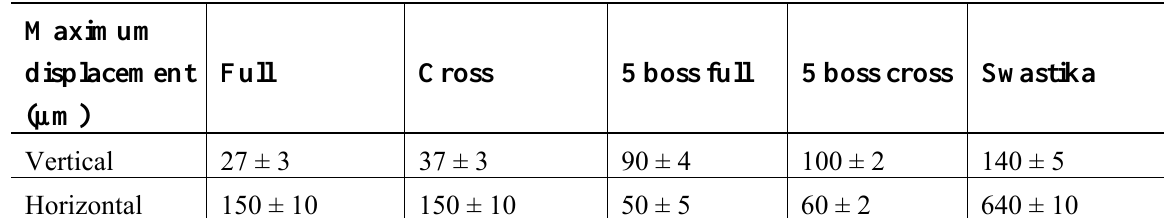
Table 4 . Summary of maximum displacement for all membrane